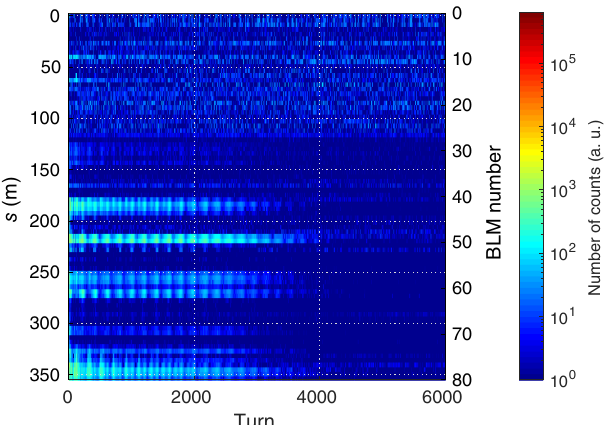
FIG. 20. Turn-by-turn losses distribution in the case of the MIK injection scheme. BLMs 1 to 25 monitor the beam losses from the injection to the MIK